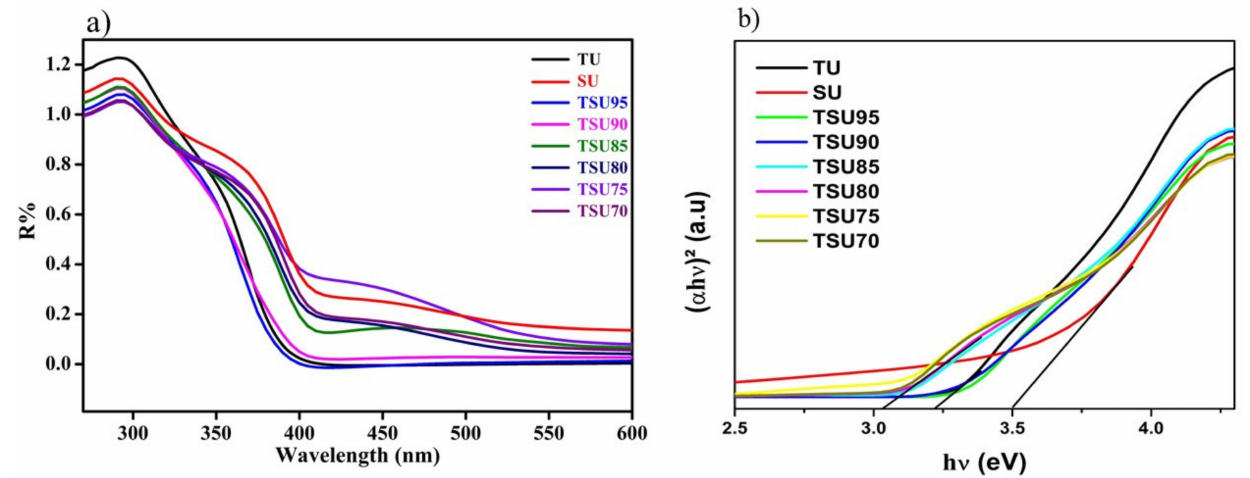
Figure 4. ( a ) UV-Vis diffuse reflectance spectra and ( b ) Tauc plot of TU, SU, TSU95, TSU90, TSU85, TSU80 and TSU75.